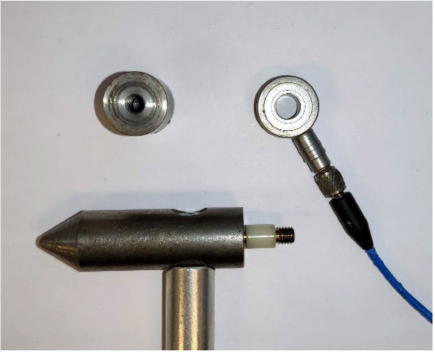
Figure 6. Circular sensor with detail of the mounting in the hammer.